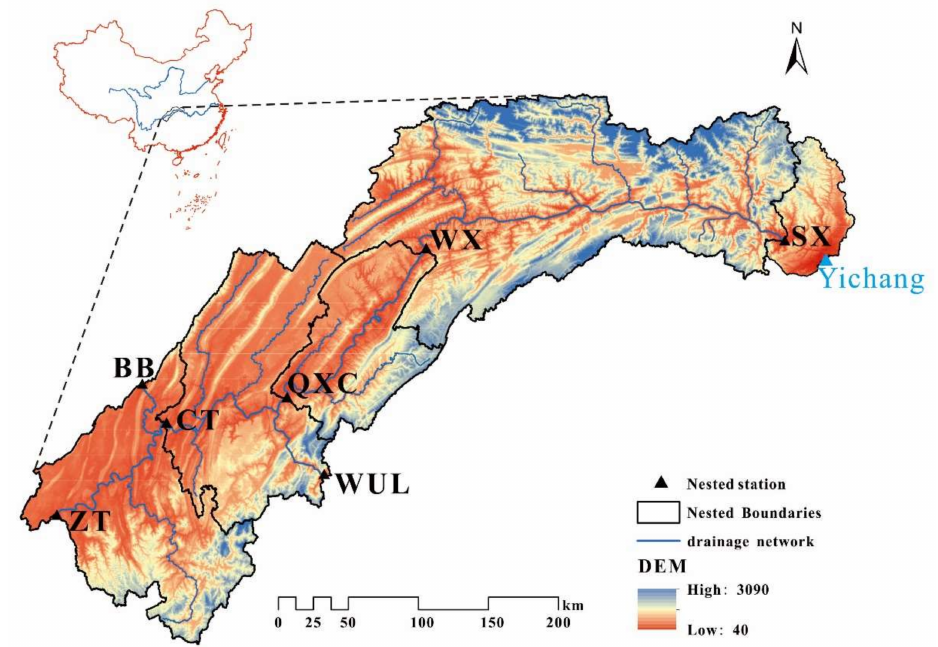
Figure 1. Map of the study area and locations of the river gauging stations. ZT, CT, QXC, WX, SX, BB and WUL stands for the Zhutuo, Cuntan, Qingxichang, Wanxian, Sanxia, Beibei and Wulong hydrometric station